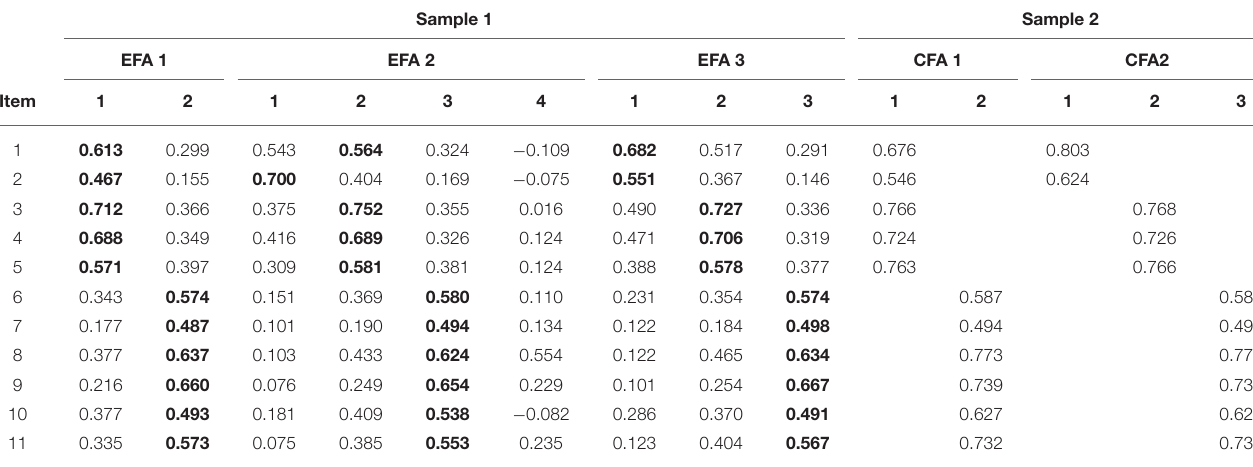
TABLE 2 | Factor loadings from factor analyses in samples 1 and 2.